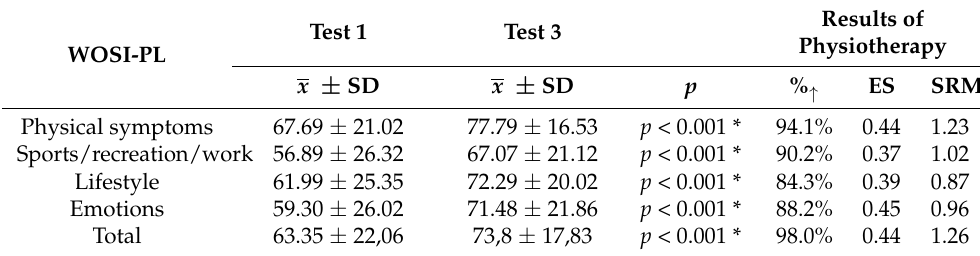
Table 6. Results of the responsiveness analysis (N = 51).